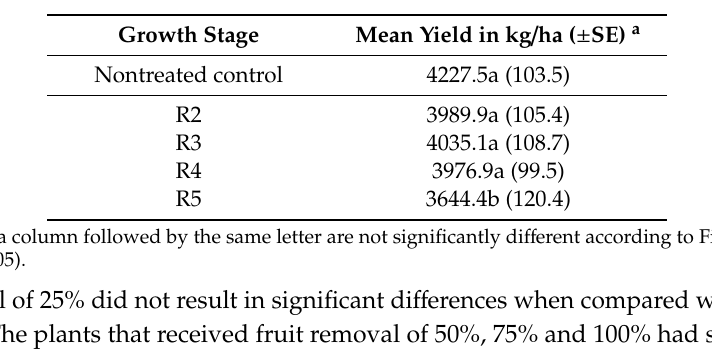
Table 3. E ff ect of the fruit removal plant stage on soybean yield during the 2016 and 2017